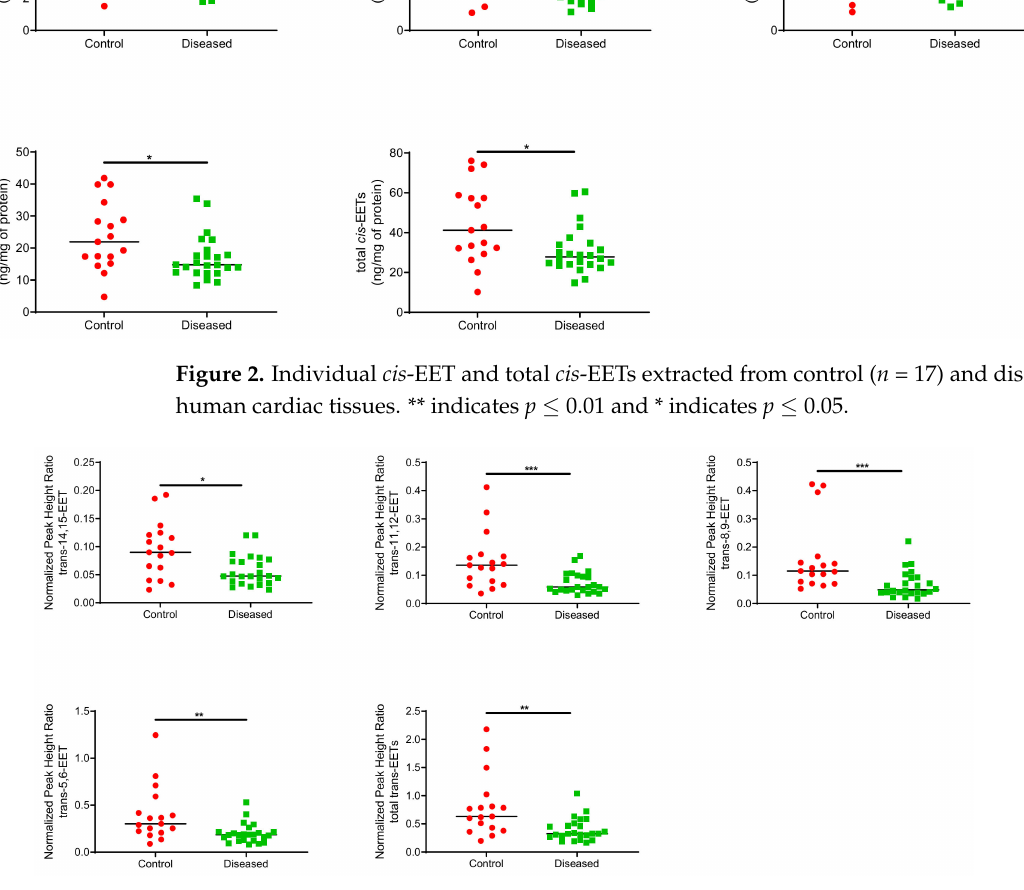
Figure 3. Normalized peak heigh ratio of each trans -regioisomer of EETs and total trans -EETs extracted from control and diseased human cardiac tissues. *** indicates p ≤ 0.001, ** indicates p ≤ 0.01, and * indicates p ≤